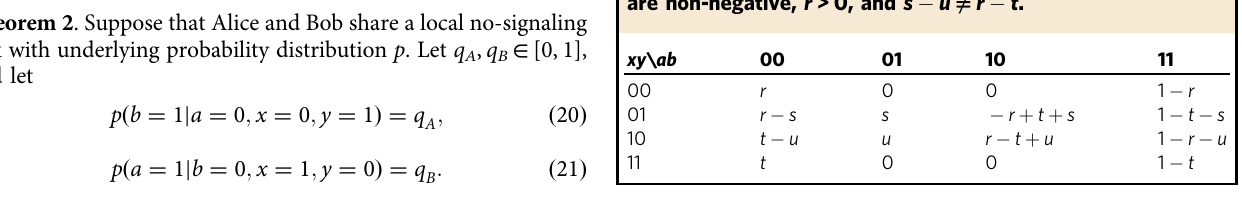
Table 1 Parametrization of two-input two-output no- signaling boxes with common certainty of